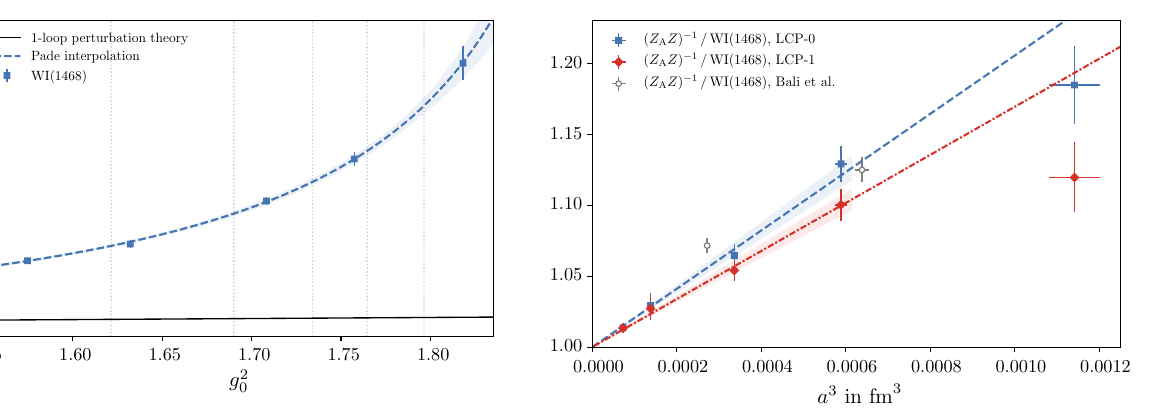
Fig. 6 Z S / Z P results from WI(1468), extrapolated to the chiral point, Fig. 7 Scaling behaviour of the ratio of Z S / Z P deduced from results plotted against the bare gauge coupling g 2 . The Padé interpolation for- 0 in Refs. [20,23] to Z S / Z P from WI(1468) mula (34), shown with errorband, is used to propagate the statistical uncertainty. The 1-loop perturbative result from Ref. [37] is shown for comparison. The vertical dashed lines indicate the CLS couplings of are quoted for two different lines of constant physics labeled Refs. [18,20,21] LCP-0 and LCP-1, which differ by the values at which the quark masses in the valence sector are kept fixed as g 0 is Table 6 Z S / Z P results from WI(1468) (second column) and from Ref. [23] for two lines of constant physics (LCP), specified there. The inverse gauge couplings β are those used in N f = 2 + 1 CLS simu- lations [18,20,21]. The error of the WI(1468) results is the statistical uncertainty propagated from the interpolation formula (34) except for β = 3 . 85 where we added a systematic uncertainty, 50% of the size of the statisticalone, in quadrature. For the results of the two LCP columns we combine the errors of Z (from Ref. [23]) and Z A (from Ref. [22])